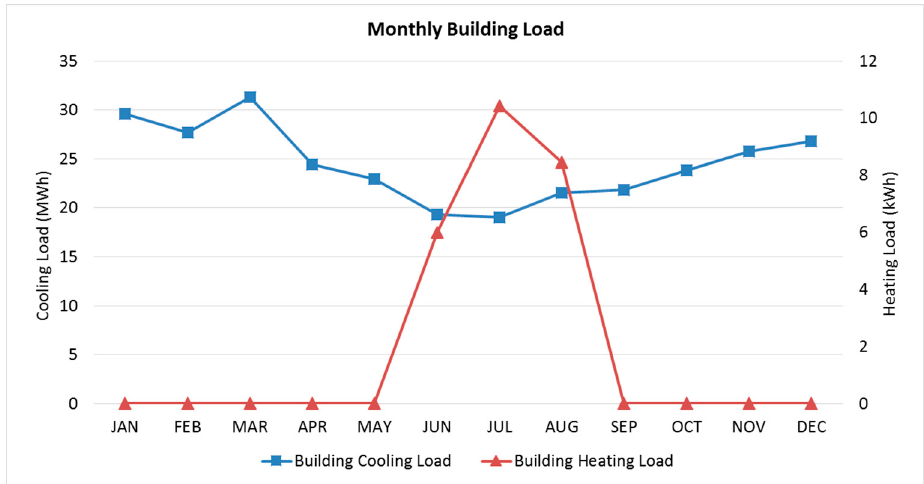
Figure 3. Monthly building cooling and heating load.